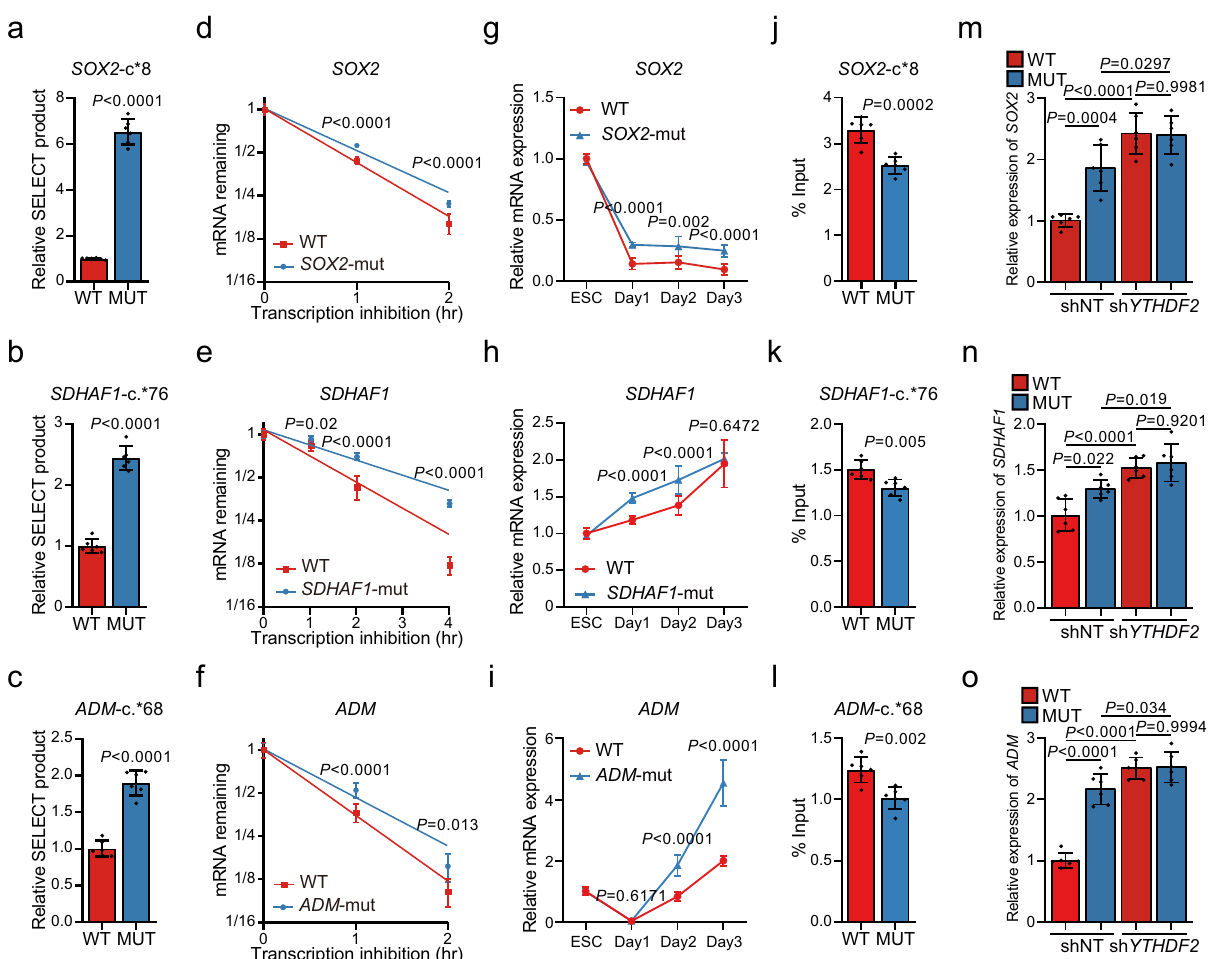
Fig. 4 Selected m 6 A disruptive mutations increase RNA stabilities depending on YTHDF2 . a – c Comparisons of SELECT-determined m 6 A levels at the targeted sites in SOX2 -mut ( a ), SDHAF1 -mut ( b ), and ADM -mut ( c ) hESCs with WT hESCs ( n = 6 biologically independent samples). P -values were calculated vs. WT (two-tailed Student ’ s t -test). d – f mRNA half-life ( t 1/2 ) of SOX2 ( d ), SDHAF1 ( e ), or ADM ( f ) in WT, and mutant hESCs ( n = 6 biologically independent samples). P -values were calculated vs. WT (two-tailed Student ’ s t -test). g – i mRNA expression levels of SOX2 ( g ), SDHAF1 ( h ), and ADM ( i ) in cultures derived from WT, SOX2 -mut, SDHAF1 -mut, and ADM -mut hESCs before and after DE differentiation measured by qPCR ( n = 8 biologically independent samples in ( g ), n = 6 biologically independent samples in ( h ) and ( i )). P -values were calculated vs. WT (two-tailed Student ’ s t -test). j – l RIP- qPCR analyses of the YTHDF2 binding at the mRNAs of SOX2 ( j ), SDHAF1 ( k ), and ADM ( l ) in cultures derived from WT and mutant hESCs at day 2 of DE differentiation ( n = 6 biologically independent samples). P -values were calculated vs. WT (two-tailed Student ’ s t -test). m – o mRNA expression levels of SOX2 ( m ), SDHAF1 ( n ), and ADM ( o ) in cultures derived from WT and mutant (MUT) hESCs at day 2 of DE differentiation with or without YTHDF2 knockdown ( n = 6 biologically independent samples). NT non-targeting; ns nonsigni fi cant (one-way ANOVA with Tukey ’ s post hoc test). Data of all relevant panels are presented as means ± SD. Source data are provided as a Source Data fi